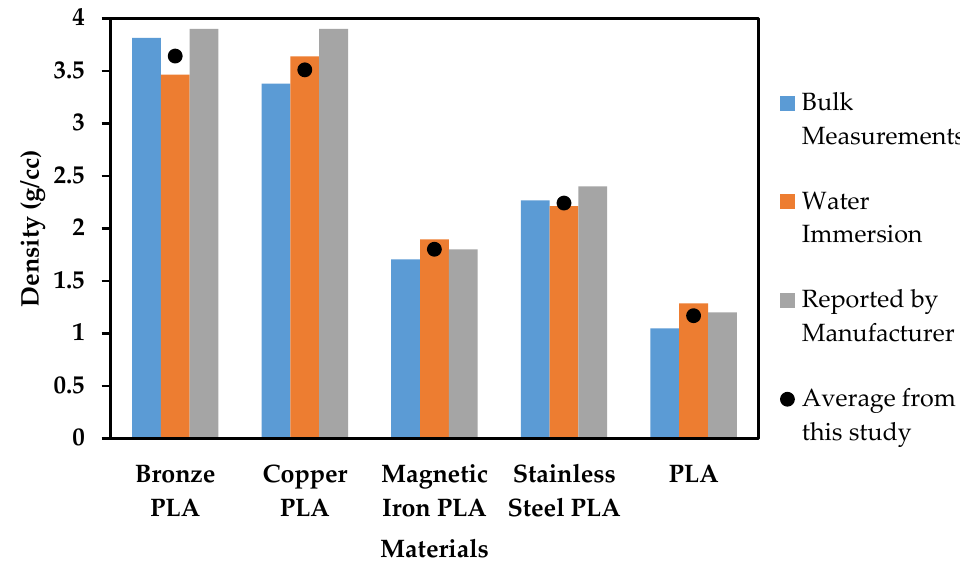
Figure 3. Filament densities obtained from multiple methods and reported by filament manufactur- ers.